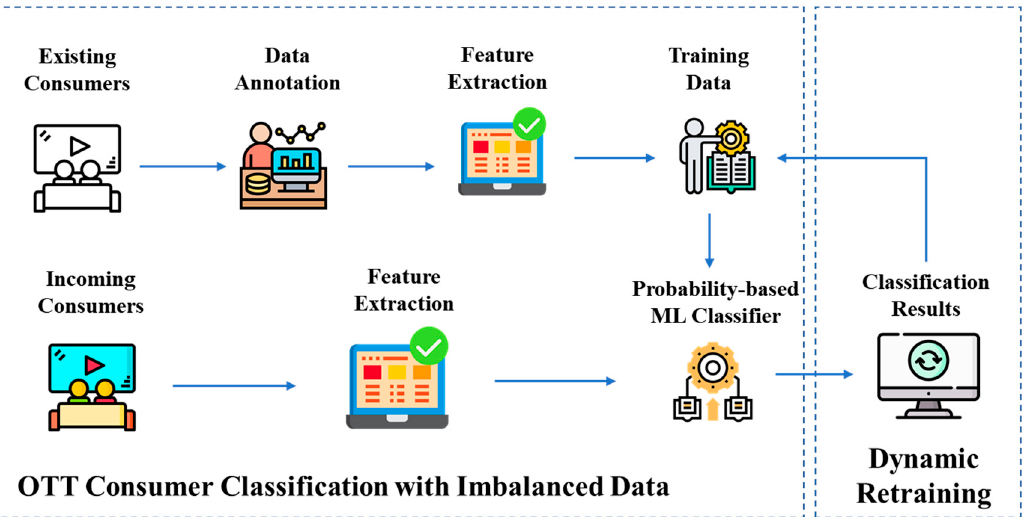
Figure 1. Modules of the proposed framework.